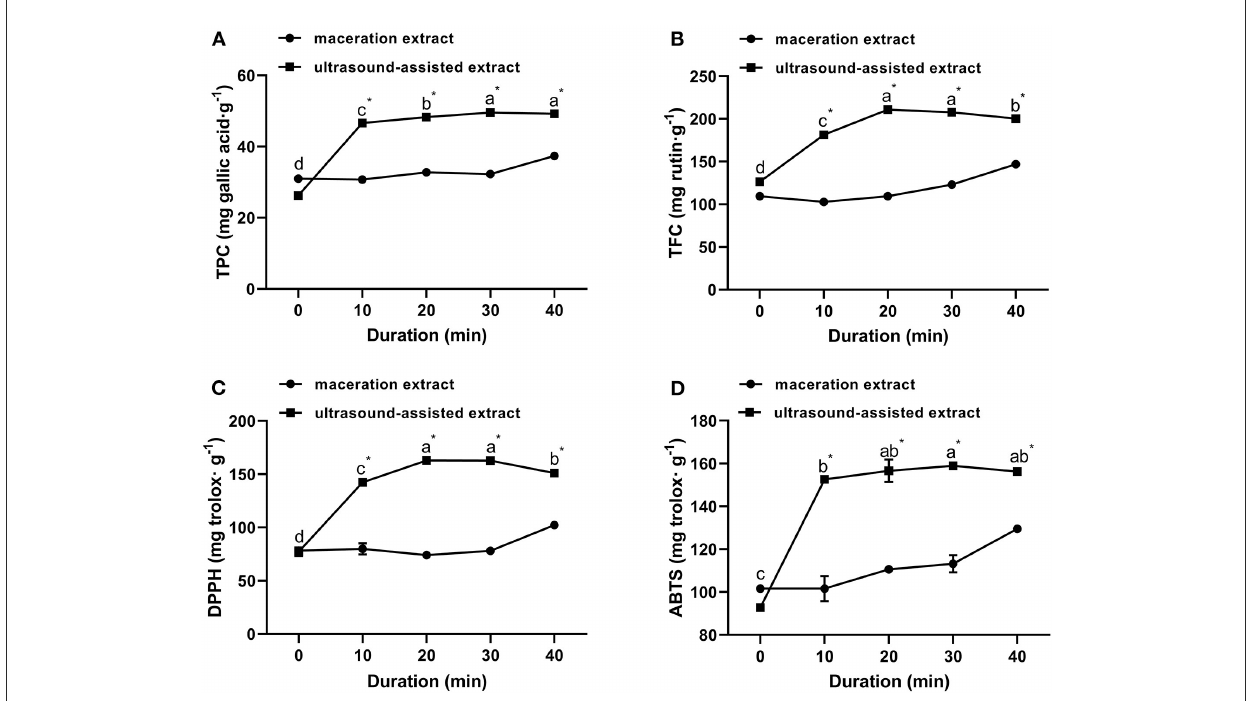
FIGURE3 Effect of ultrasound duration on TPC (A) , TFC (B) of propolis extracts and their antioxidant activities meassured by DPPH (C) and ABTS (D) assays (ultrasound power: 135W). Different superscripts on the same curve indicate significant differences as estimated by Duncan’s multiple range test ( P < 0.05); “*” indicates significant difference as estimated by Duncan’s multiple range test ( P < 0.05) between maceration extract and ultrasound extract.